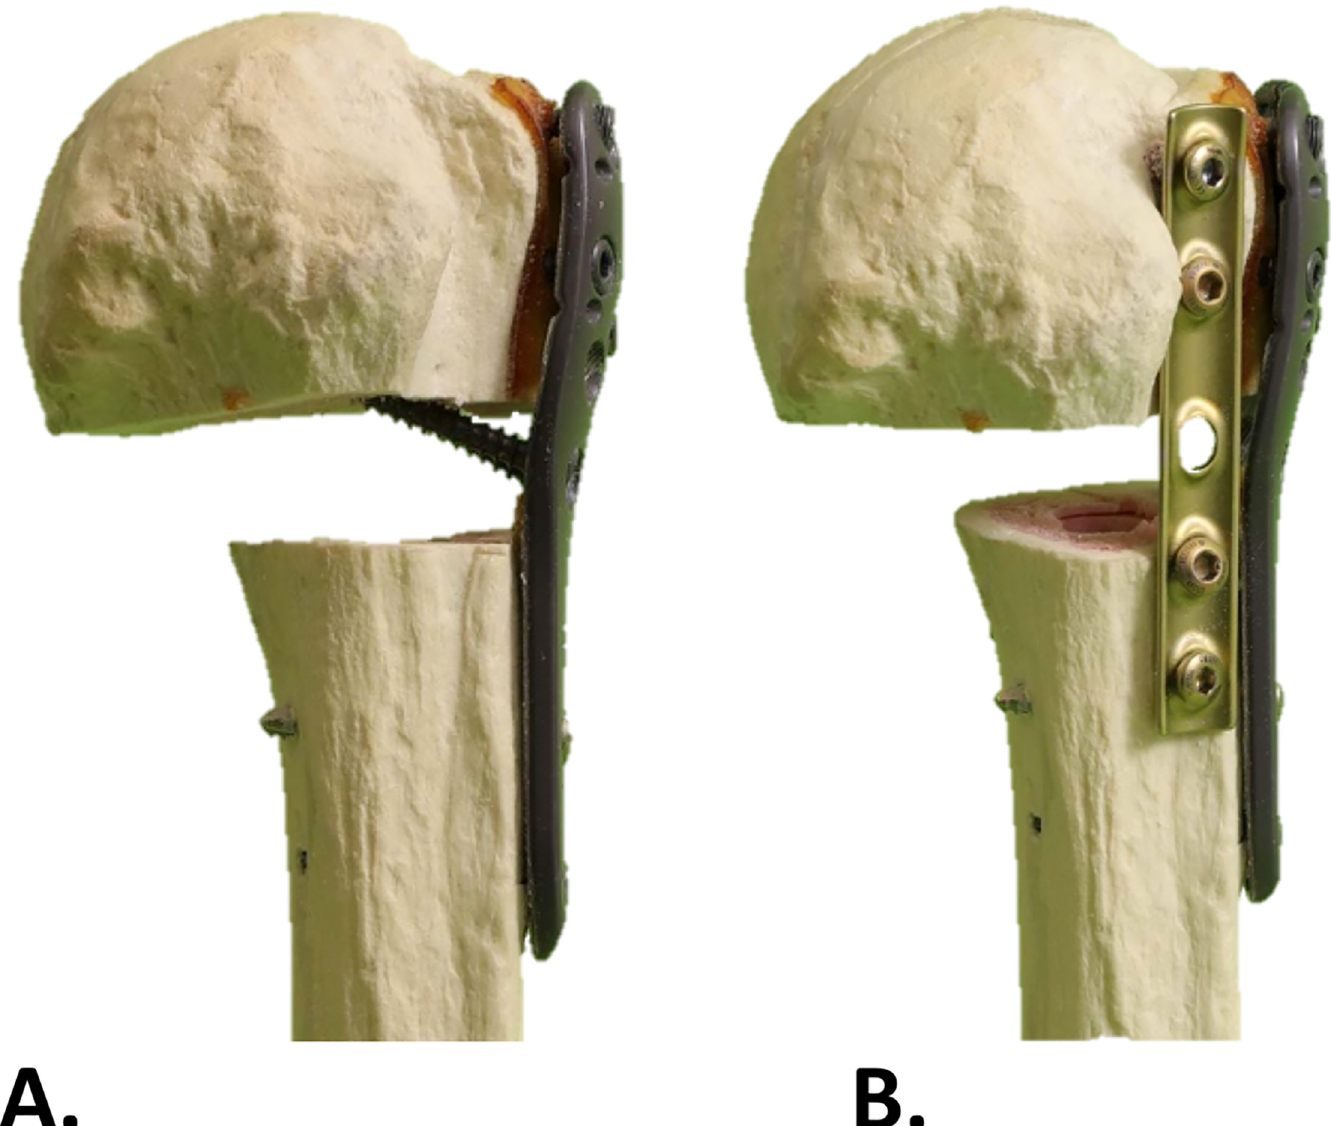
Fig 2. A. Group 1: supplied with a locking plate, five locking screws and two additional screws for medial support B. Group 2: supplied with the same locking plate setup as group 1 with an inverted five-hole one-third tube plate placed in the bicipital sulcus.